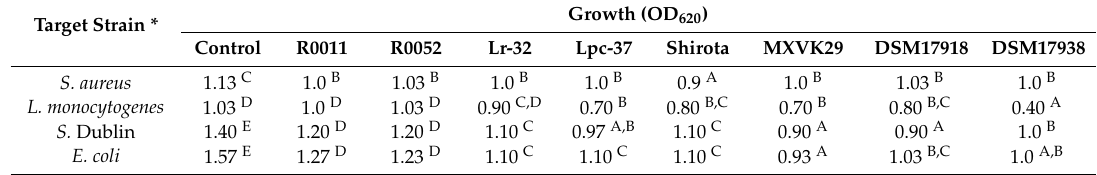
Table 4. Antimicrobial activity of probiotic strains against pathogens associated with fermented sausages. Target Strain *